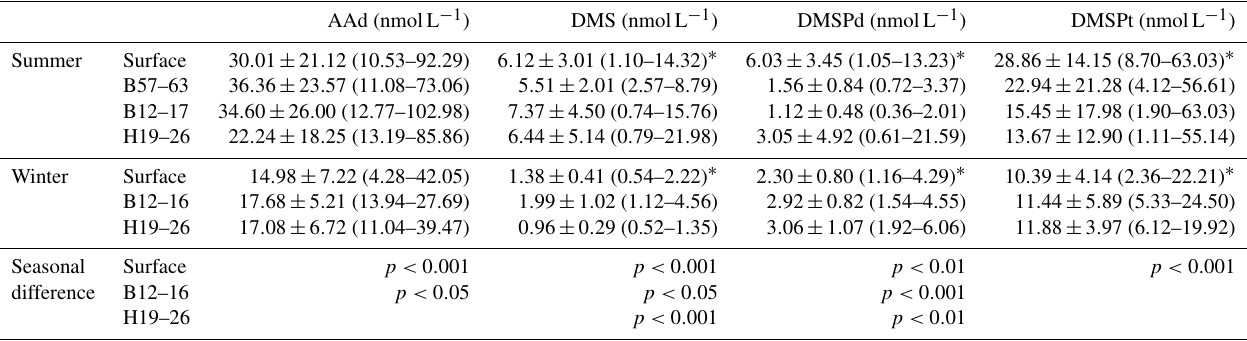
Table 1. Summary of the mean values (ranges) and the significance of seasonal differences of AAd, DMS, DMSPd, and DMSPt in the surface seawater of the BS and YS and the entire vertical profiles of transects during summer and winter. The significance of seasonal differences was obtained using the Mann–Whitney